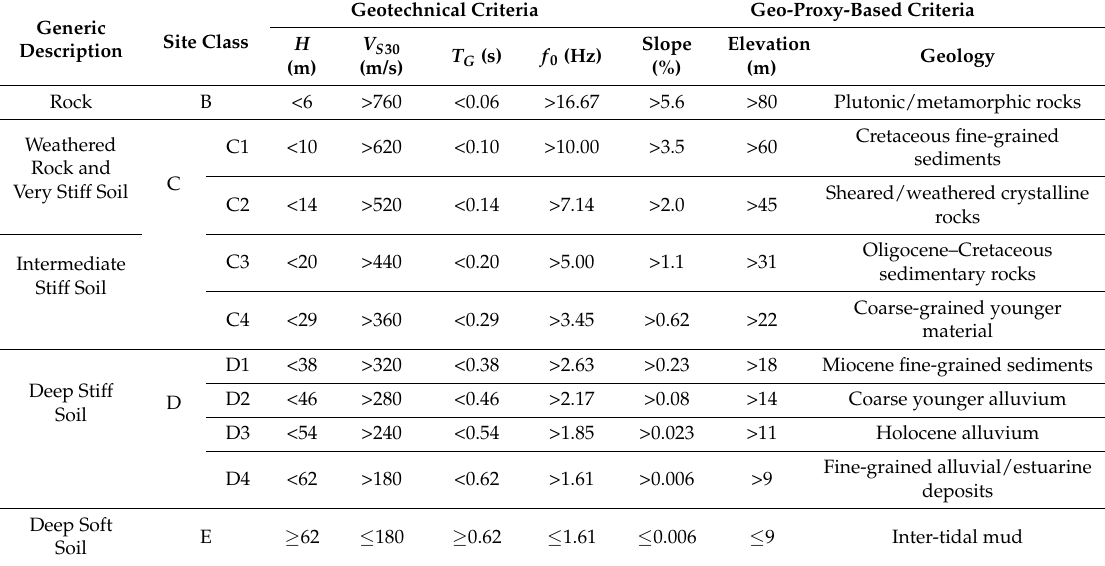
Table 2. Site classification criteria for multivariate site response parameters (modified after